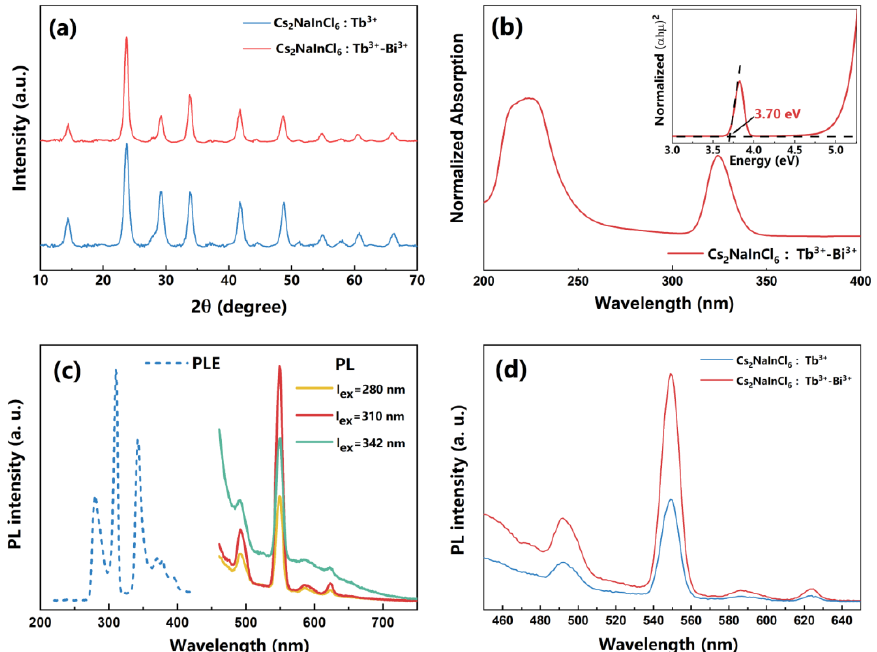
Figure 3. ( a ) PXRD patterns of the Tb 3+ -singly-doped and Tb 3+ -Bi 3+ -co-doped Cs 2 NaInCl 6 NCs. ( b ) Diffuse reflection absorption spectrum; insert shows the corresponding Tauc plots of the Tb 3+ -Bi 3+ -co-doped Cs 2 NaInCl 6 NCs. ( c ) PLE and PL spectra of the Tb 3+ -Bi 3+ -co-doped Cs 2 NaInCl 6 NCs. ( d ) PL spectra of the Tb 3+ -singly-doped and Tb 3+ -Bi 3+ -co-doped Cs 2 NaInCl 6 NCs.